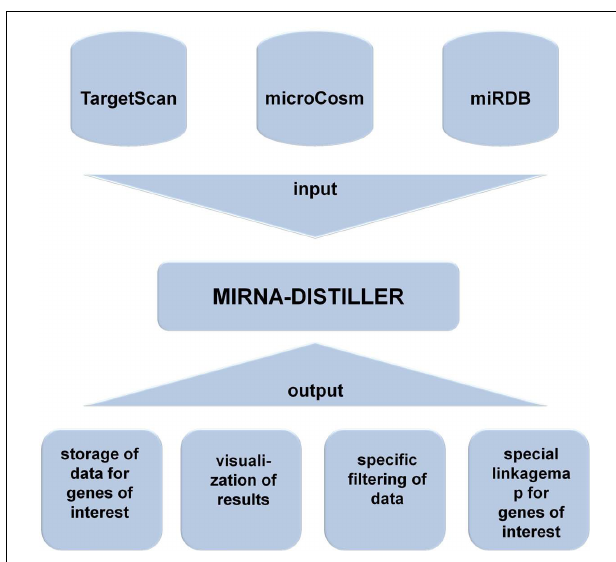
FIGURE 1 | Overview of design and implementation of the MIRNA-DISTILLER. The program extracts miRNA predictions for any genes of interest provided byTargetScan, miRBase, and miRDB. Local storage of the retrieved data, application of several filtering options, visualization of the results, and generation of pair wise linkage maps are the main functions of the